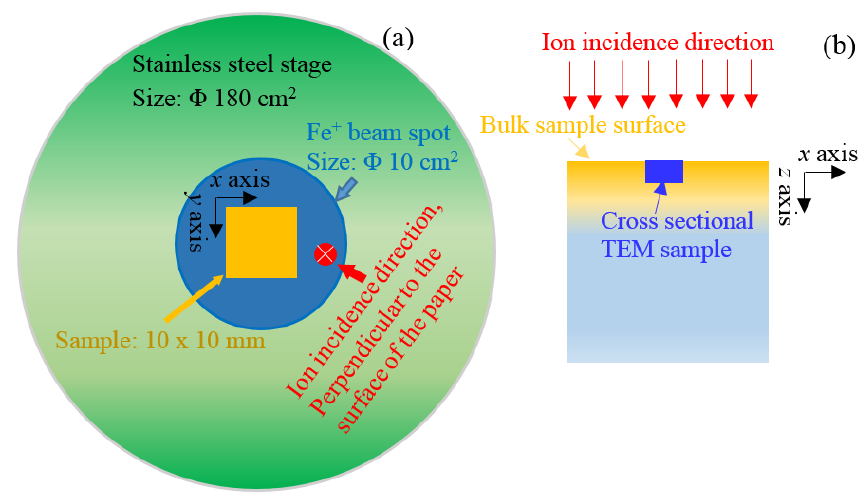
Figure 1. ( a ) The sketch of the samples in the ion implanter and ( b ) the location of TEM foil from the irradiated sample.